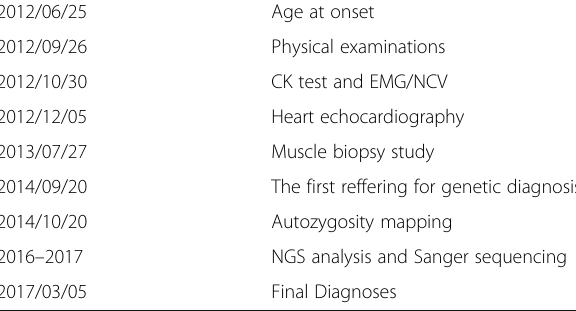
Table 1 Timeline of diagnosis the